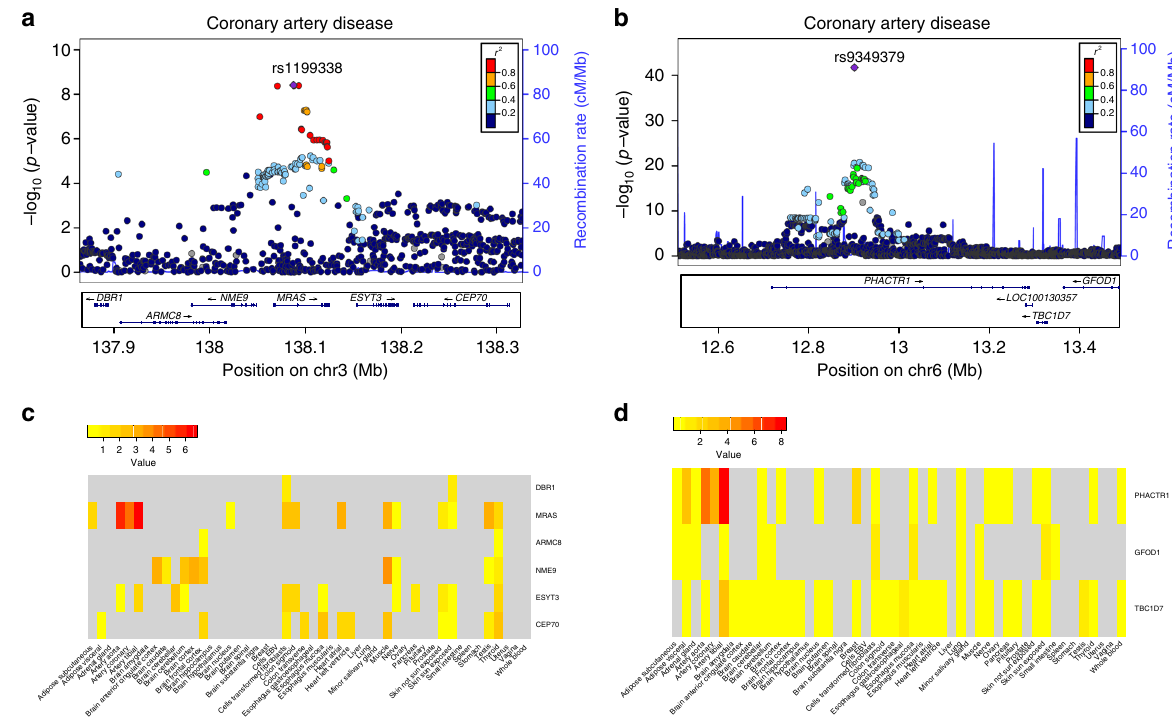
Fig. 5 Tissue-speci fi c effects of MRAS and PHACTR1 on coronary artery disease. a , b Top. Association plot showing genome-wide signi fi cant loci for coronary artery disease in the MRAS a and PHACTR1 b gene regions. Representation of single-SNP association strengths ( y axis shows the − log 10 p value) versus genomic positions (on hg19/GRCh37 genomic build; x axis) around the most signi fi cant SNP, indicated with a purple dot. Other SNPs in the region are color coded to re fl ect their LD with the top SNP (according to pair-wise r 2 values from 1000 Genomes Project phase 3 haplotypes). Bottom. Genes and position of exons and respective transcriptional strands. c , d Tissue-speci fi c causal effects. Genes listed on y axis; tissues listed on x axis. Darker points correspond to stronger associations. Genes highlighted in gray were not tested. MRAS and PHACTR1 show signi fi cant association only in arterial